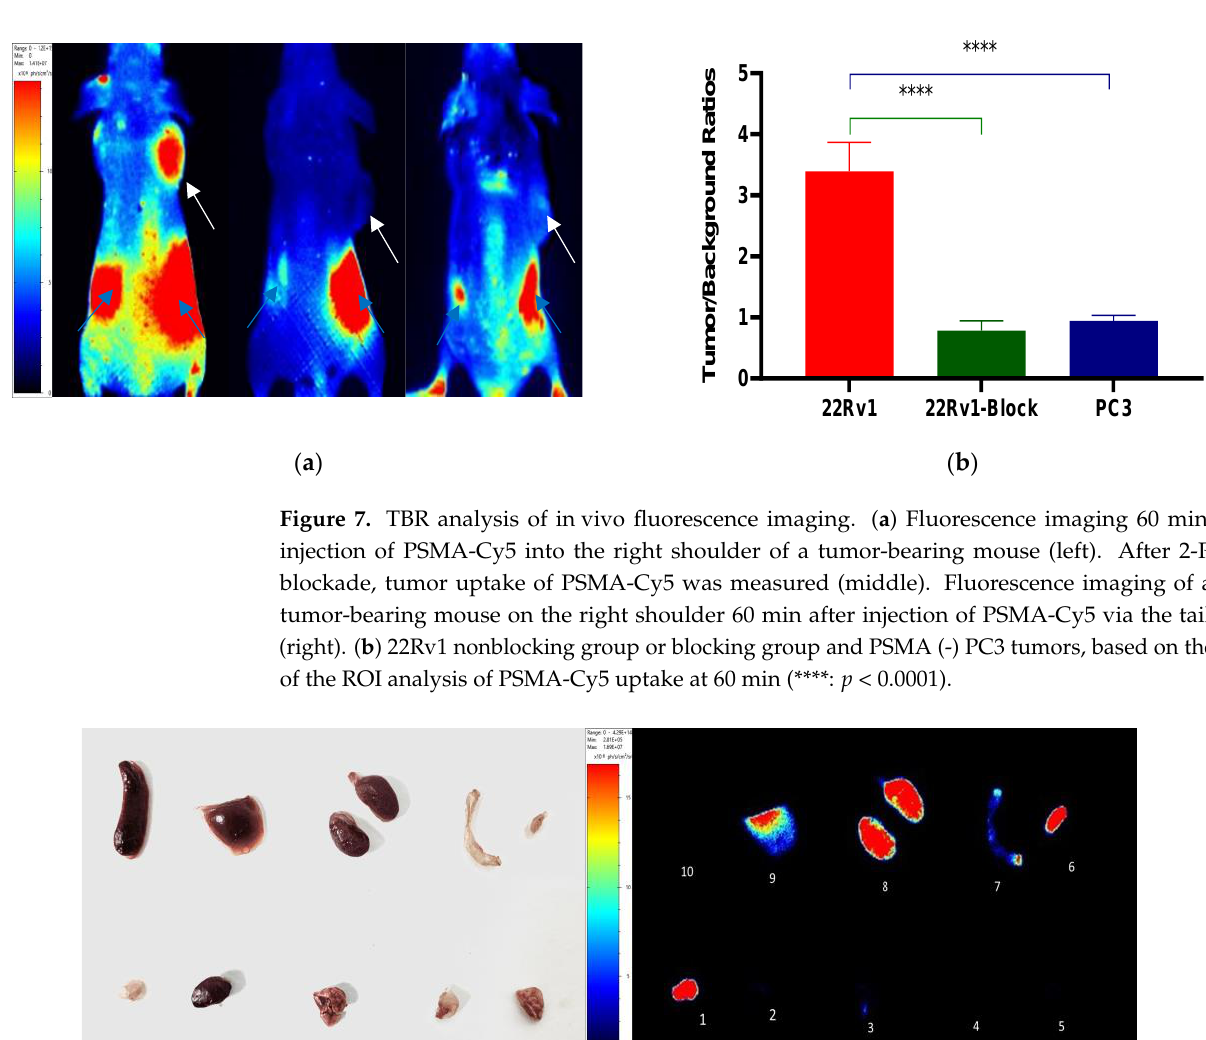
( b ) Figure 6. Quantitative analysis of the ROI of in vivo fluorescence imaging. ( a ) Fluorescence imaging of 22Rv1 tumor-bearing mice after tail vein injection of PSMA-Cy5 (0.5 mg/kg). The tumor can be clearly seen at 30 min, 60 min, and 120 min (indicated by white arrows). The fluorescence intensity